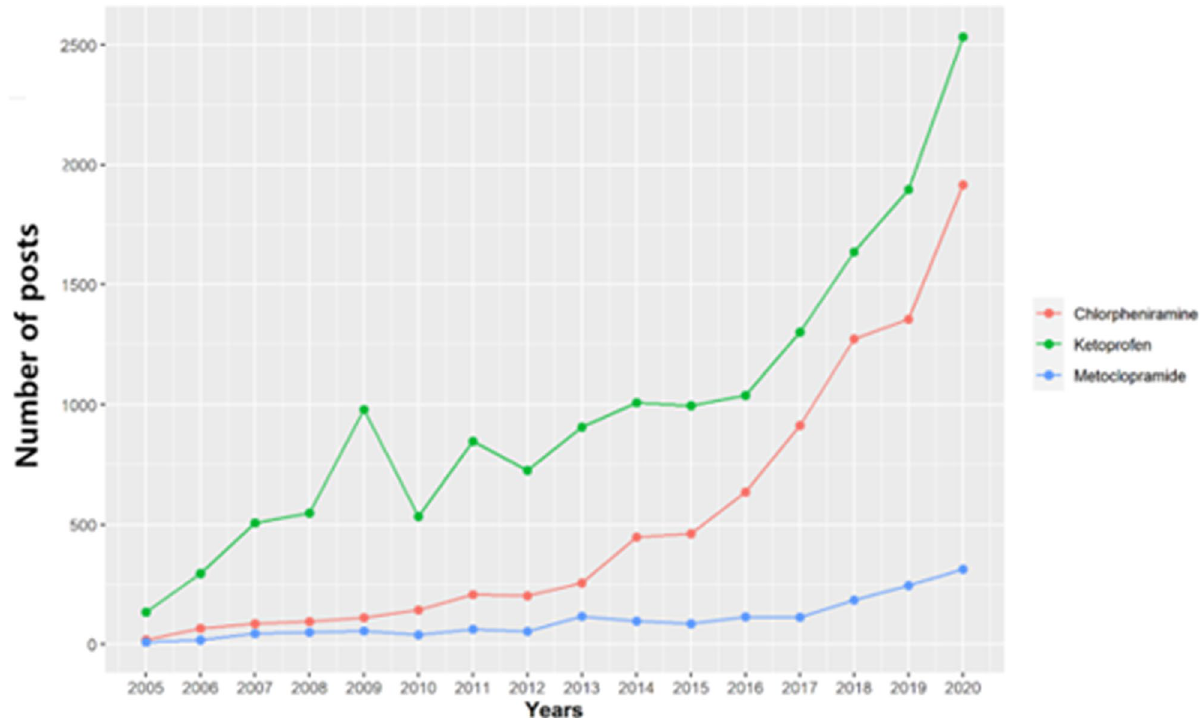
Figure 3. Trends analysis. Curation of articles mentioning each target drug.